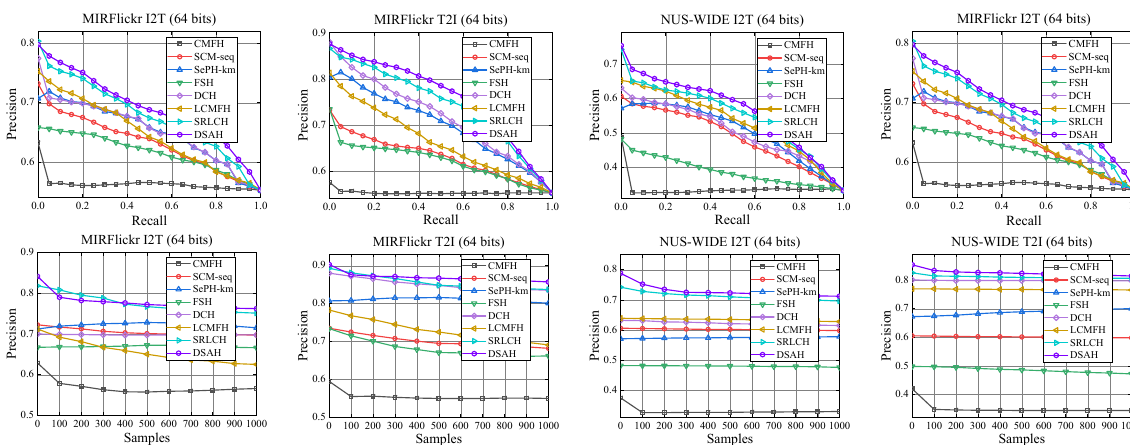
Figure 2. Precision–Recall and P@ k curves obtained by different baselines and tested on MIRFlickr and NUS-WIDE datasets.